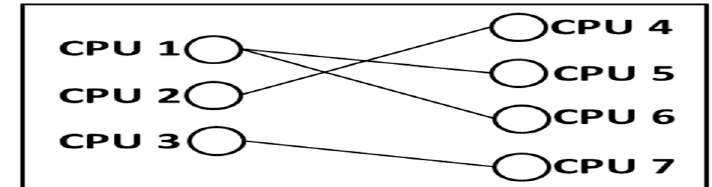
Figure 20. Processors having different tasks in a simultaneous fashion.